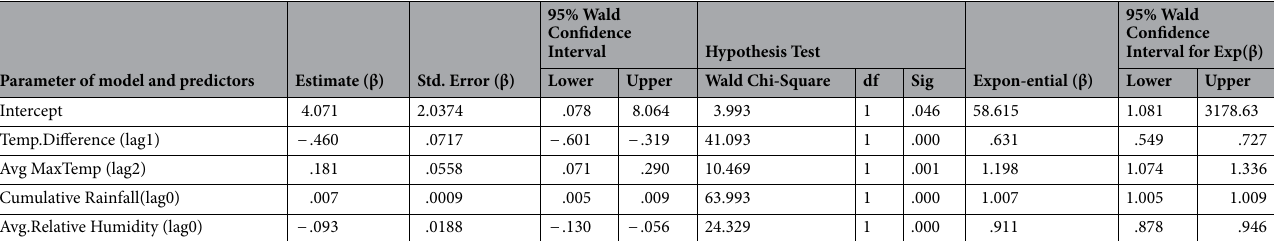
Table 3. The generalized linear model using negative binomial regression analysis of the data and the environmental predictors of dengue (2015–2018). Dependent variable: Dengue cases (number).